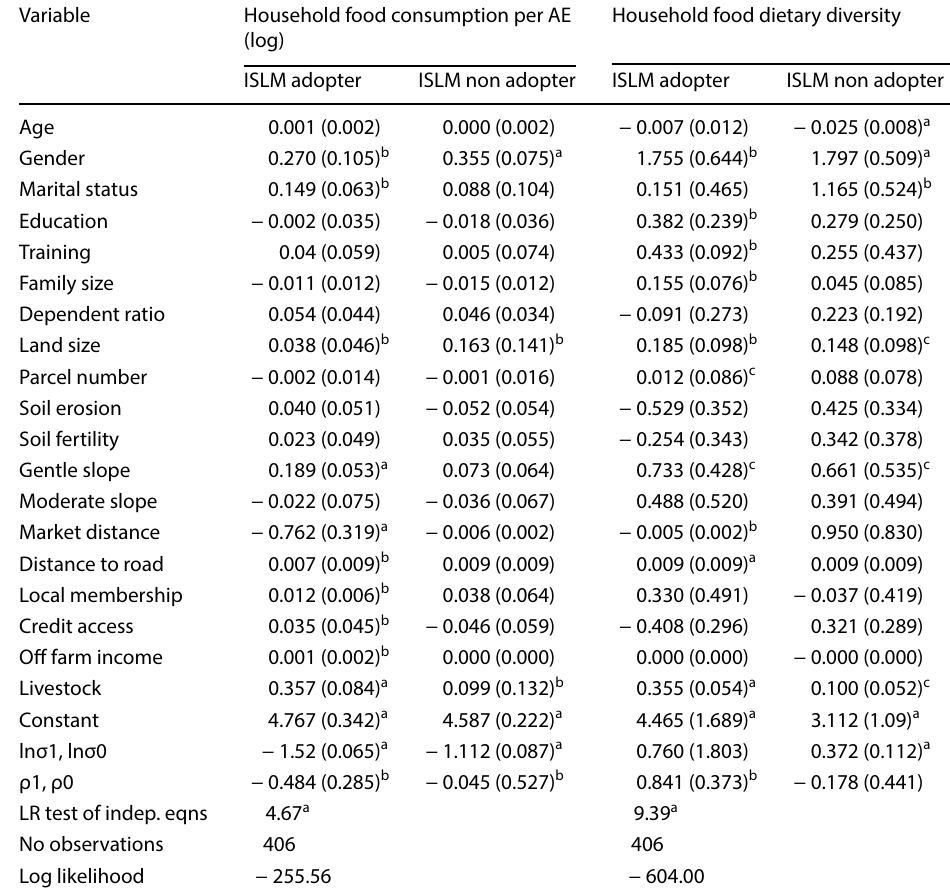
Table 3 ESR results for household food consumption and dietary